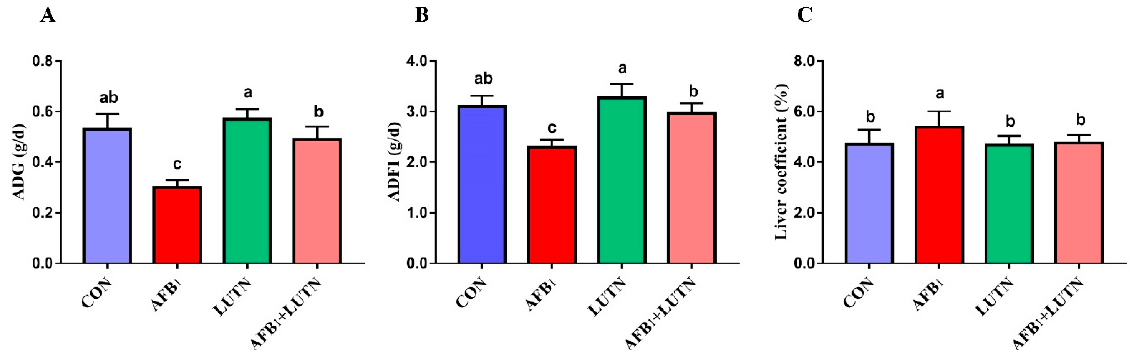
Figure 1. Luteolin treatment alleviates growth retardation of mice induced by aflatoxin B 1 . ( A ) Average daily gain (ADG), ( B ) average daily feed intake (ADFI) and ( C ) liver coefficients (%). The results are presented as mean ± SD (n = 12). a–c Columns with different lowercase letters indicated significant differences between the compared groups ( p < 0.05).